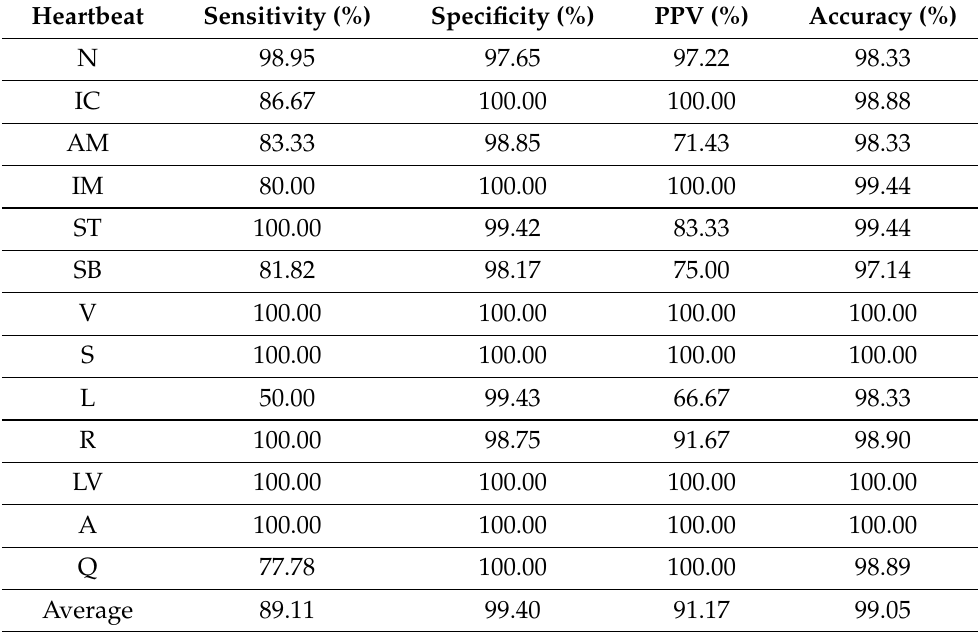
Table 10. Evaluation of Performance Metrics on D1.